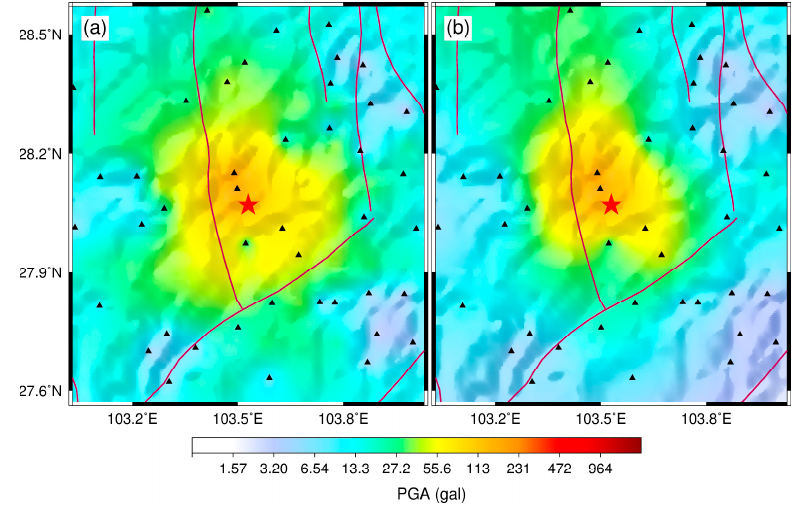
Figure 7. PGA shake maps for the 16 May 2018, M 4.3 Shimian earthquake ( a ) with and ( b ) without virtual stations. PGA values for the virtual stations were derived using the ground-motion prediction equation proposed in Yu’s study [41]. The triangles represent the GL-P2B stations, while the star indicates the epicenter of this earthquake.